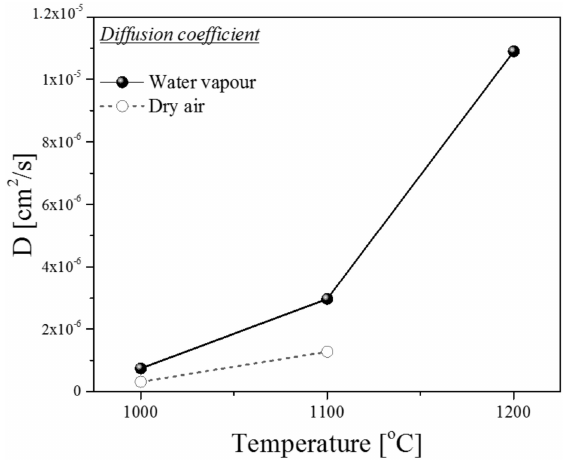
Figure 16. Di ff usion coe ffi cient as a function of temperature. Table 4. Values of oxidation rate and di ff usion coe ffi cient in oxides formed at high temperatures. Q: the activation energy for di ff usion in the oxide